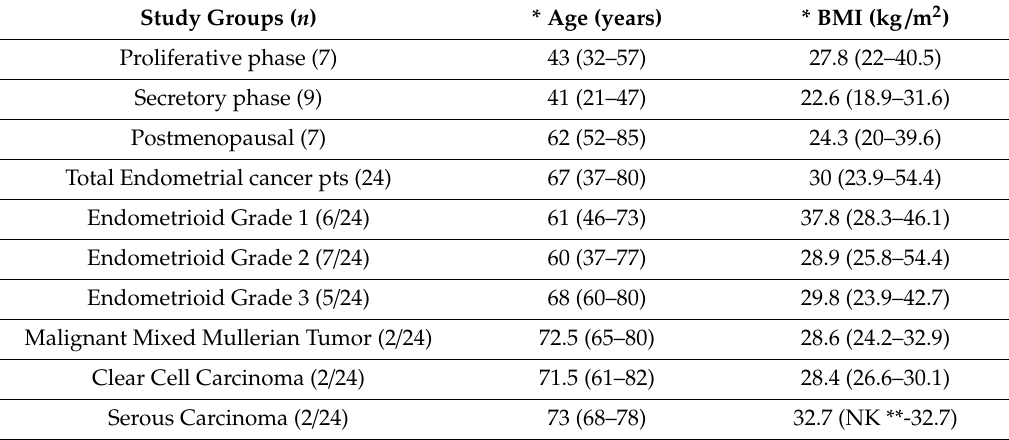
Table 2. Demographic features of study